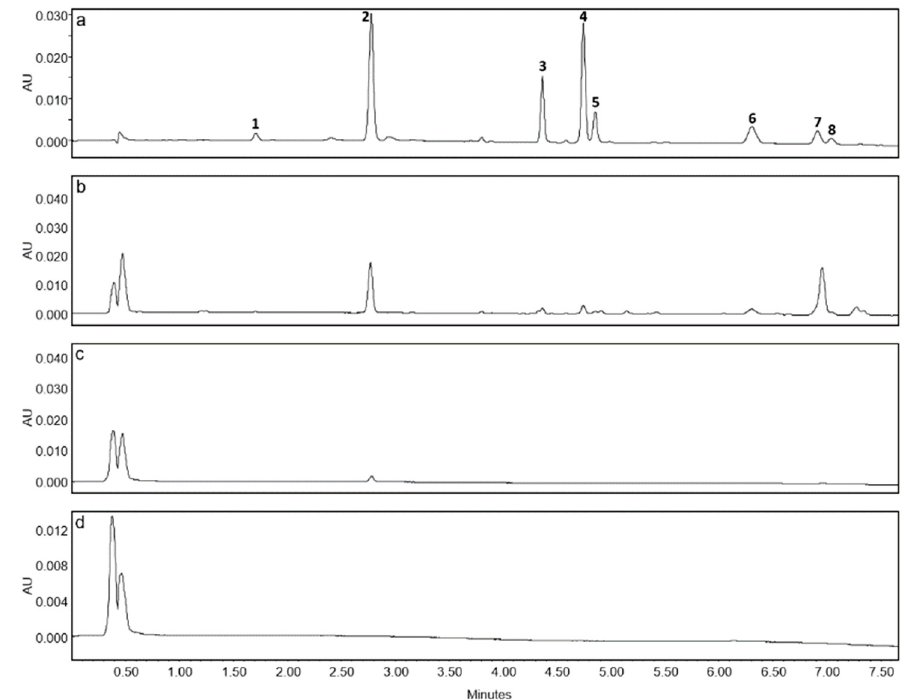
Figure 2. LC-UV chromatograms (370 nm) of crude extracts prepared at 100 µg/mL in MeOH for ( a ) cones and 1 mg/mL in MeOH for ( b ) leaves, ( c ) stems and ( d ) rhizomes. Compounds identified are as follows: desmethylxanthohumol ( 1 ) rt 1.70 min, xanthohumol ( 2 ) rt 2.78 min, cohumulone ( 3 ) rt 4.37 min, humulone ( 4 ) rt 4.75 min, adhumulone ( 5 ) rt 4.86 min, colupulone ( 6 ) rt 6.31 min, lupulone ( 7 ) rt 6.92 min, adlupulone ( 8 ) rt 7.05 min.